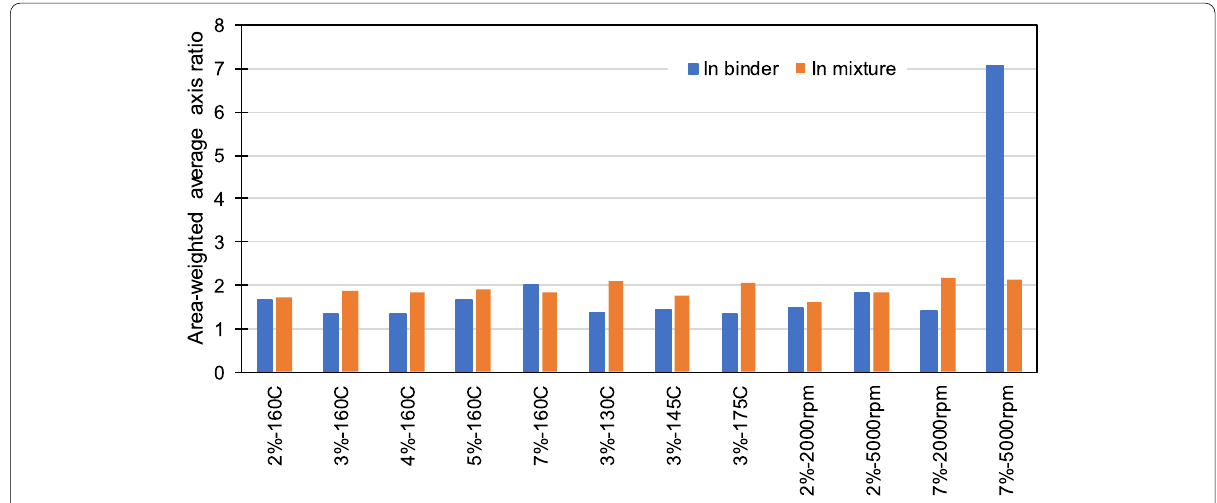
Fig. 15 Comparison of SBS area-weighted average axis ratio in asphalt binder and their